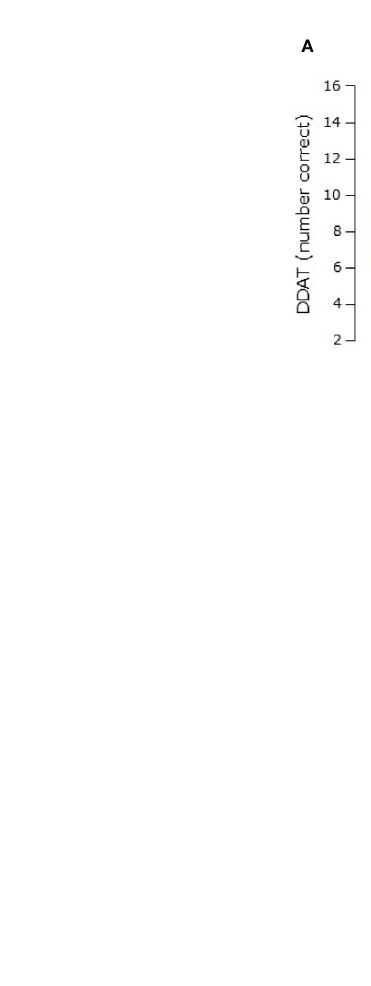
FIGURE 5 | (A) Double digit addition testing (DDAT) before and after each series of shifts. (B) Total number of correct answers in DDAT for each shift. Scores increased signi fi cantly over the three shifts during both treatment arms (P < 0.0001 overall) and were higher during melatonin treatment (P < 0.0001 overall). Box and whisker plots show median, interquartile, and full range (n =